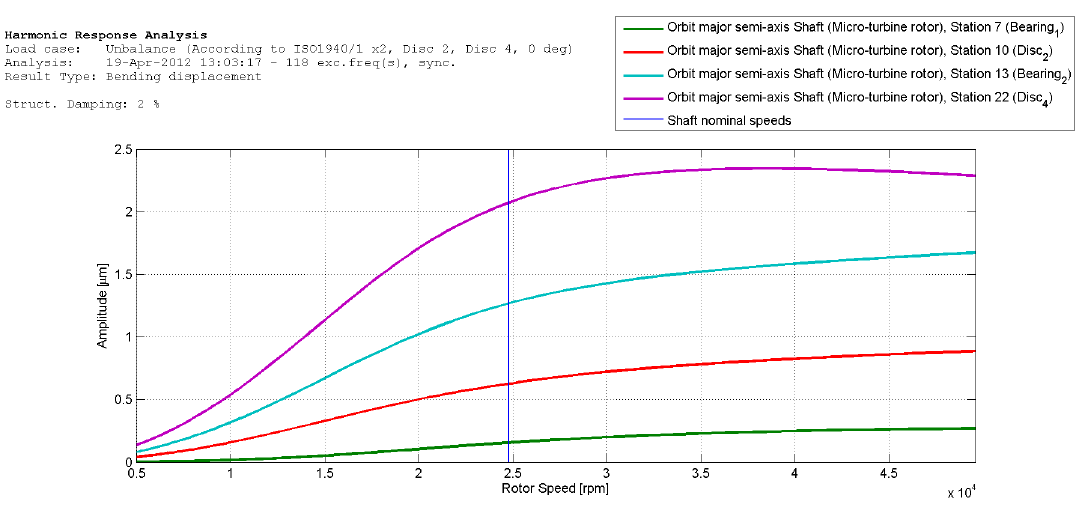
Figure 14: Amplitude of the rotor vibration for the unbalance of the discs No. 2 and No. 4 equal to 2.4 × 10 −6 kg · m.